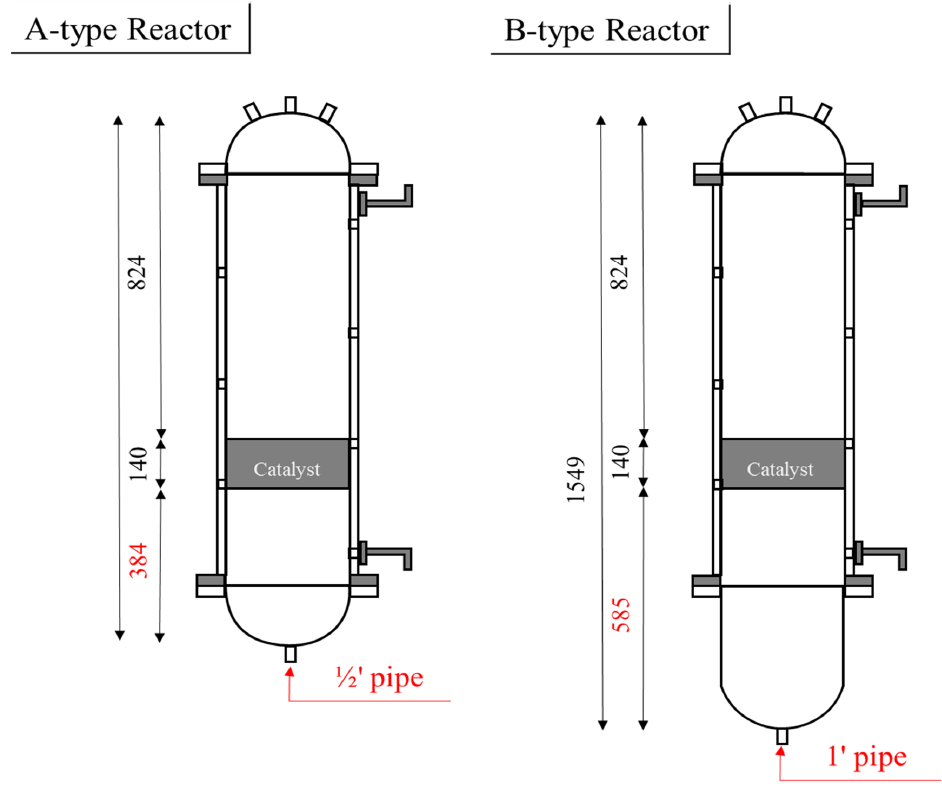
Figure 12. Schematic of the CO 2 methanation reactor.